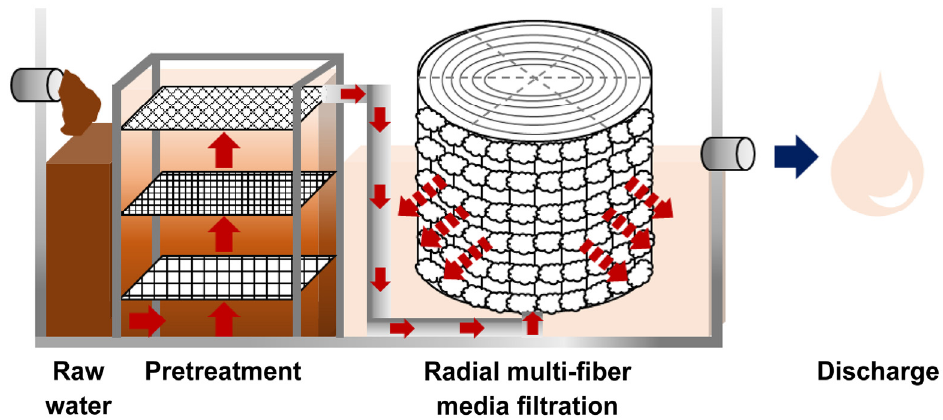
Figure 1. Schematic of the radial multifiber media filtration process for CSOs.